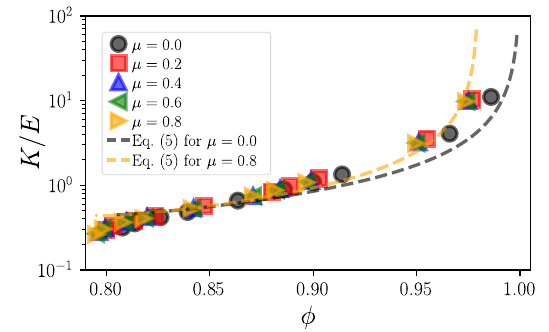
Figure 4. Evolution of the macroscopic bulk modulus as a func- tion of the solid fraction for di ↵ erent values of interparticle co- e  cient of friction µ . The dashed lines are drawn using Eq. (5) fitting cases µ = 0 . 0 (black) and µ = 0 . 8